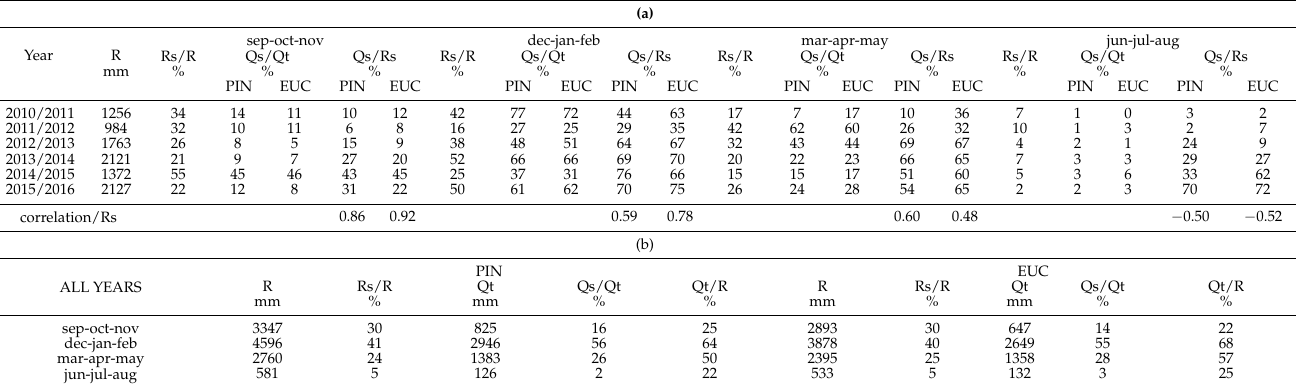
Table 5. ( a ) Seasonal changes in streamflow regime over the study period in the pine (PIN) and eucalypt (EUC) catchments. ( b ) Average seasonal changes in streamflow regime over the six hydrological